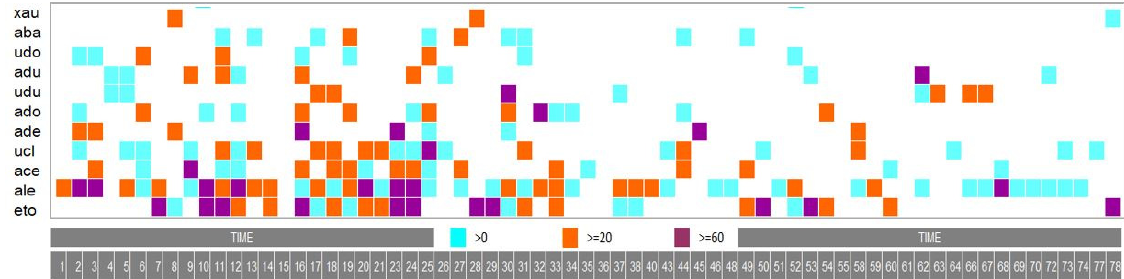
Figure 16. The dynamics of the eleven guests in the sample.